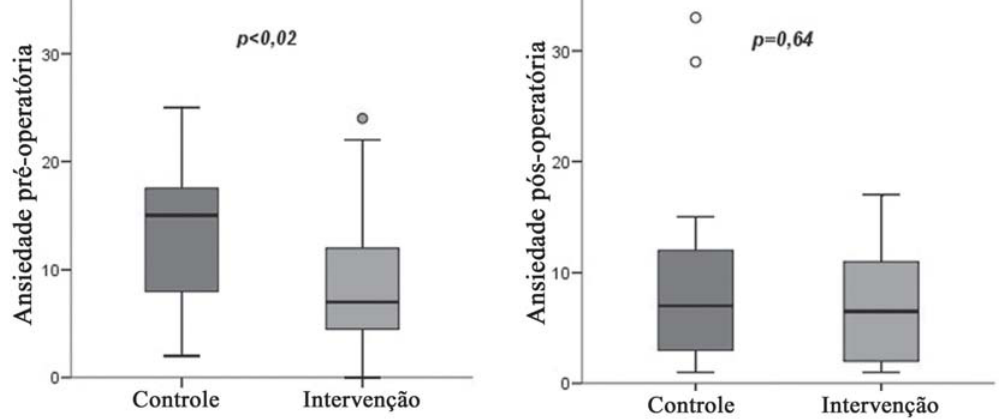
Fig. 1 - Escore de ansiedade. A: pré-operatório; B: pós-operatório